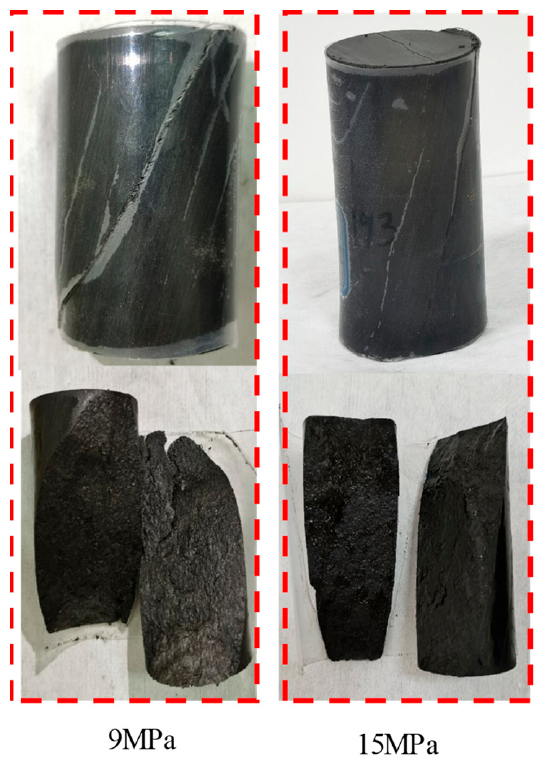
Figure 9. Failure characteristics of dolomitic limestone samples under triaxial creep compression tests with multi-stage loading at confining pressures of 9 MPa and 15 MPa.